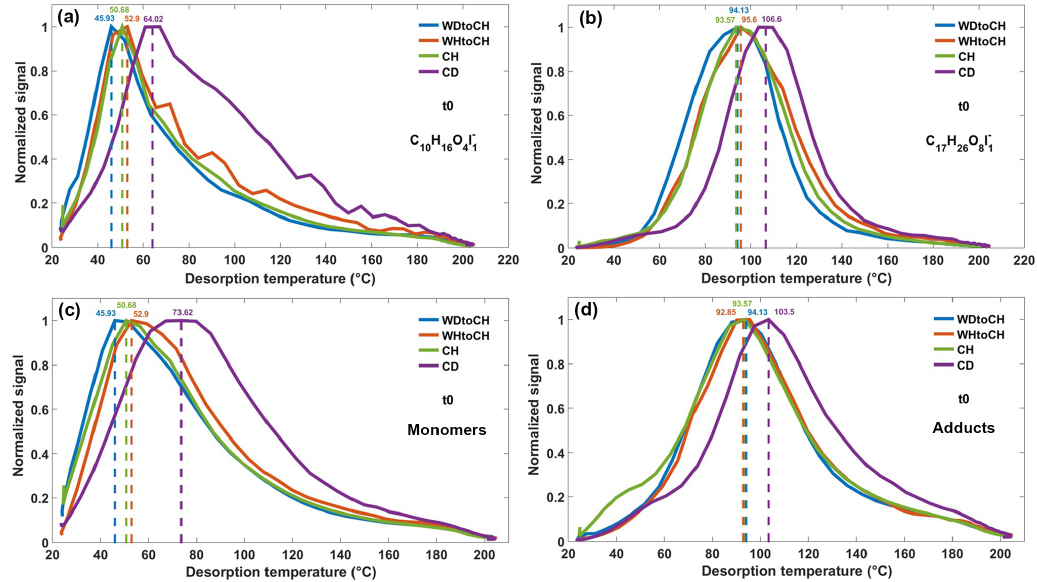
Figure 6. Thermograms of monomer C 10 H 16 O 4 (a) and adduct C 17 H 26 O 8 (b), both clustered with I − at t 0, and sum thermograms of monomers (c) and adducts (d) at t 0. Dashed lines refer to the corresponding T max